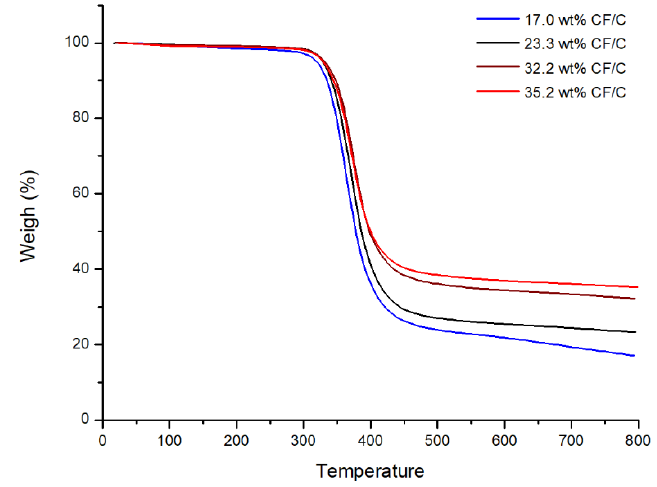
Figure 6. The curve of the TGA.